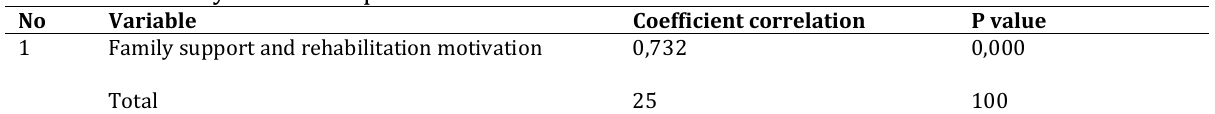
Table 3. Data analysis via the Spearman rho